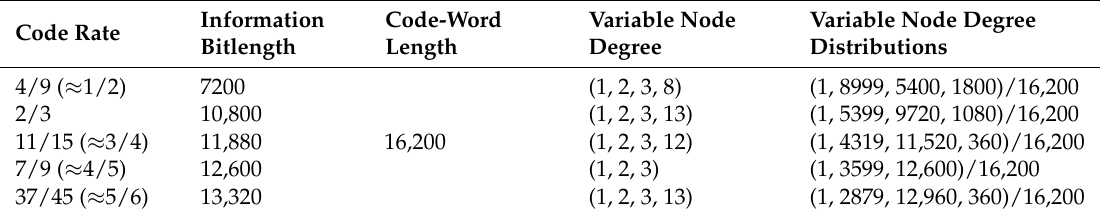
Table 2. Parameters of the short codes in the DVB-S2